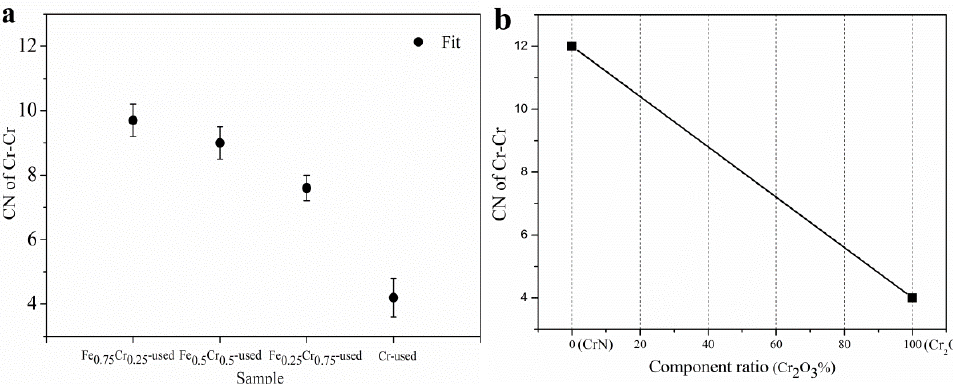
Figure 8. ( a ) Cr-Cr shell coordination numbers by EXAFS fitting data of used FeCrO x catalysts, and ( b ) Cr-Cr shell coordination numbers as a function of proportions between CrN and Cr 2 O 3 model. According to the standard curve of the coordination numbers, corresponding to the